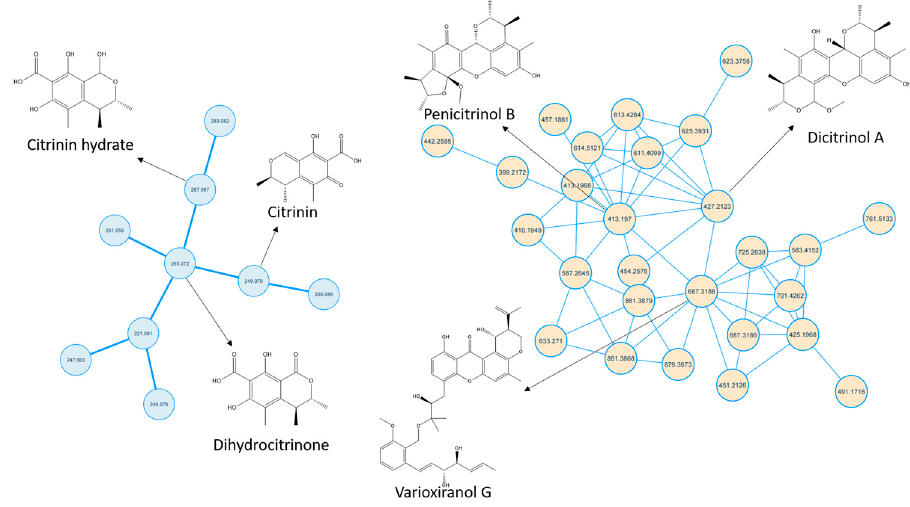
Figure 3. Citrinin, citrinin dimers and related metabolites spectral families. The node label represents precursor mass ( m / z ).